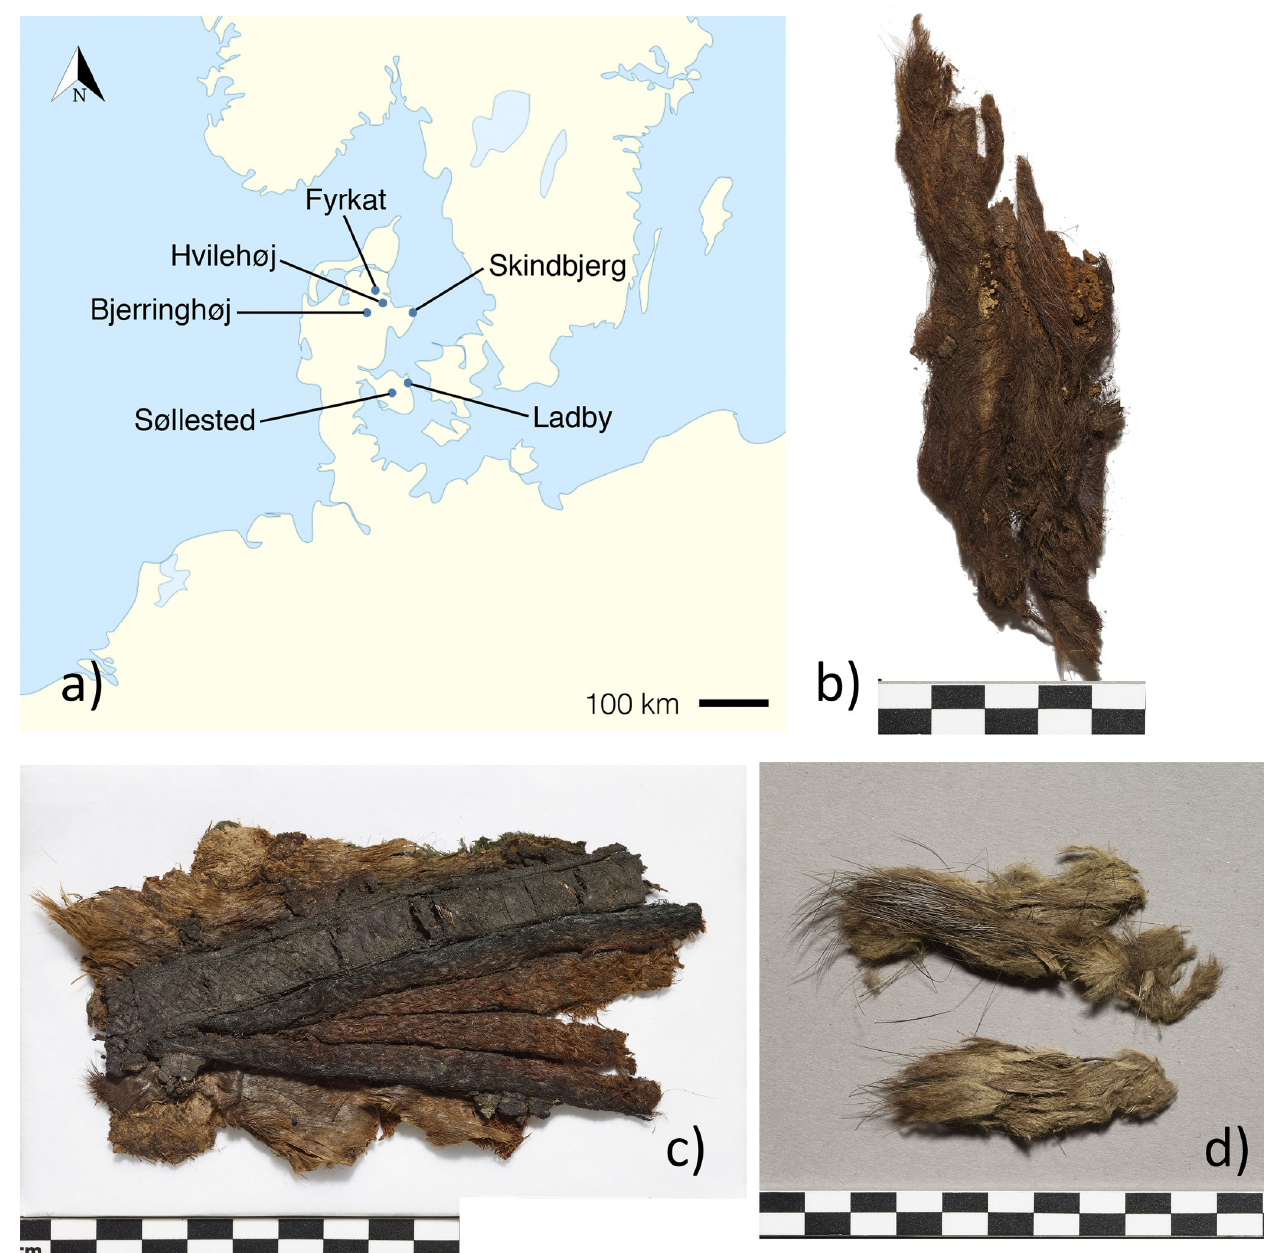
Fig 1. Map of studied sites (a) and examples of included fur: b) Hvileh ø j C4273-97, fragment 1, c) Hvileh ø j C4280c, d) Bjerringh ø j C143. Graphics: Luise Ø rsted Brandt and Charlotte Rimstad. Photos: Roberto Fortuna, National Museum of